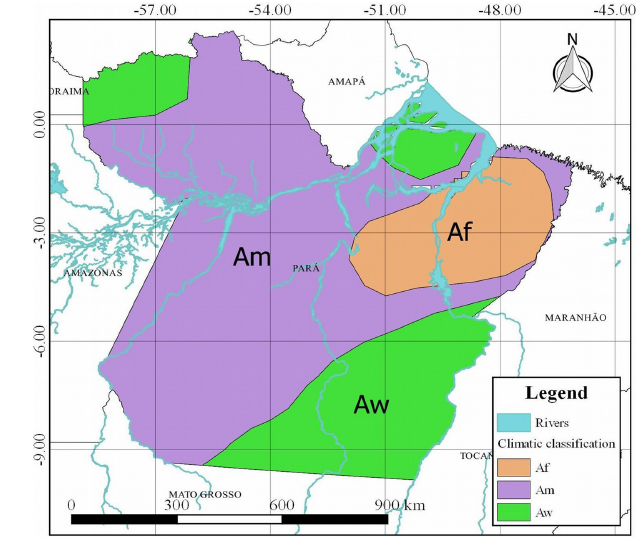
Figure 3. Climatic characterization of the state of